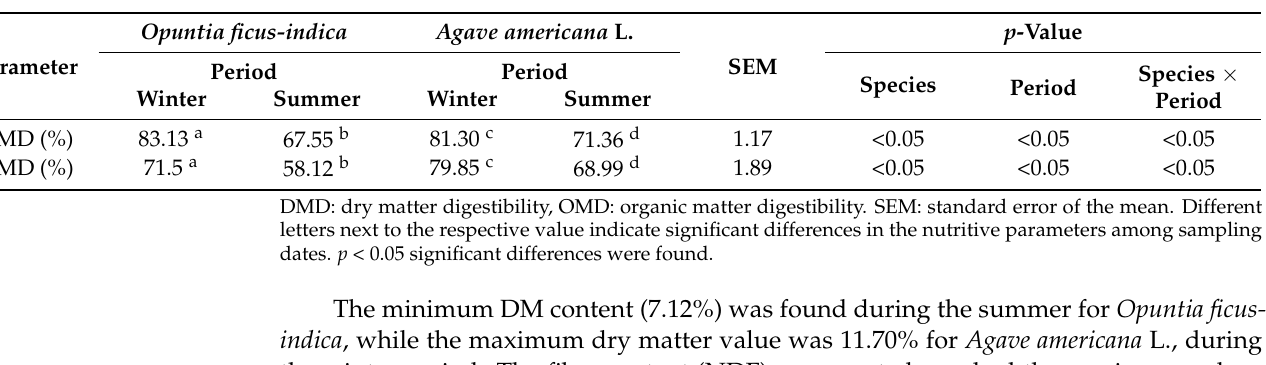
Table 2. Percentage dry matter digestibility (%DMD) and percentage organic matter digestibility (%OMD) of the different plants to the different